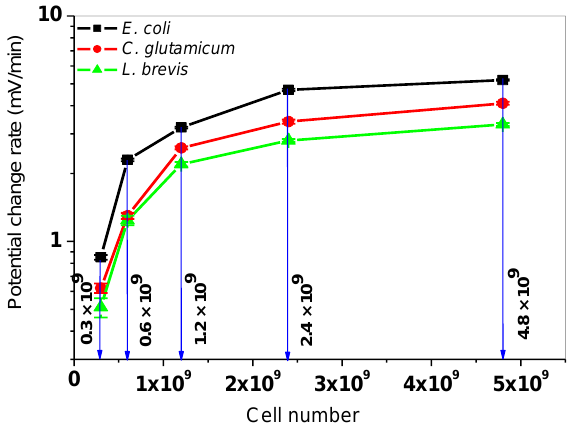
Figure 7. Correlation between the LAPS signal response and the cell number at a fixed glucose concentration of 1.67 mM. Mean values and standard deviations of PCR values of E. coli (black), C. glutamicum (red), and L. brevis (green) are depicted for different cell numbers (0.3 × 10 9 , 0.6 × 10 9 , 1.2 × 10 9 , 2.4 × 10 9 , 4.8 × 10 9 cells in 200 µL cell suspension). Three independent measurements were performed, and within the first 6 min after adding cells, the mean PCR values were calculated.